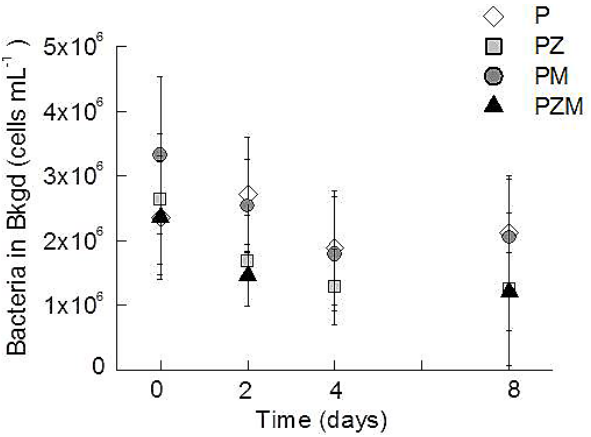
Fig. 7. Abundance of bacteria in the suspended in the background water.